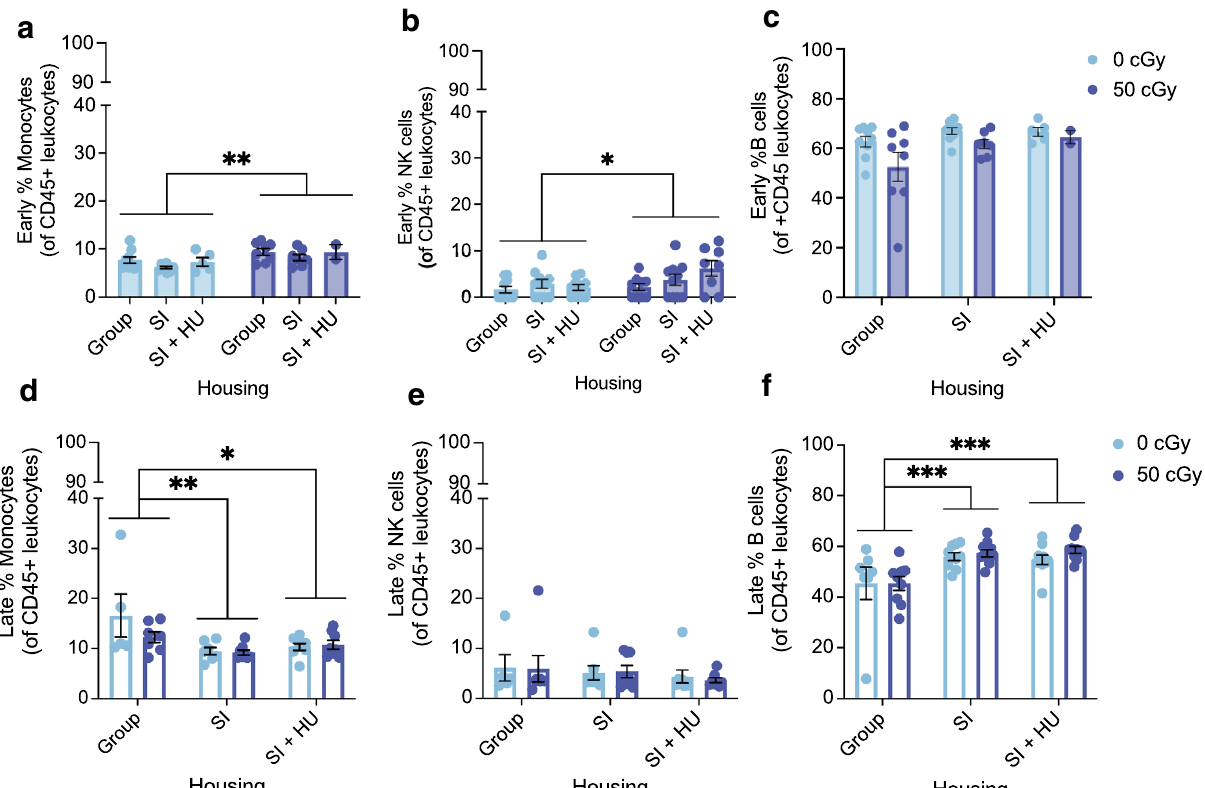
Figure 5. Combined stressors effects on early and late blood. Blood was collected from tail vein 3 weeks after GCRsim irradiation ( a, b, c ) and cardiac puncture at euthanasia ( d, e, f ). Percentages are of CD45 + cells. ( a ) Males exposed to 50 cGy had higher % monocytes than 0 cGy controls (F (1, 34) = 9.448, p = 0.004, η 2 = 0.217) (mean diff 1.921, 95%CΙ (0.651 to 3.190), p = 0.004). ( b ) There was a main effect of GCRsim on % NK cells (F(1,50) = 4.756, p = 0.034, η 2 = 0.087). Males exposed to 50 cGy had a higher % NK cells than controls (mean diff 1.801, 95%CI (0.142 to 3.459), p = 0.034). ( c ) % B cells trended toward a main effect of housing (F(1,34) = 3.179, p = 0.054, η 2 = 0.158) and of GCRsim (F(1,34) = 3.474, p = 0.0709, η 2 = 0.093). Males: n = 9 for Group 0 cGy, SI 0 cGy, n = 8 for Group 50 cGy, n = 7 for SI 50 cGy, n = 5 for SI + HU 0 cGy, n = 2 for SI + HU 50 cGy. ( d ) %Monocytes had a significant main effect of housing, F(2,37) = 6.382, p = 0.004, η 2 = 0.256. Group housed mice had higher % Monocyte levels than SI (mean diff. 5.096%, 95%CI (1.411 to 8.780), p = 0.004) and SI + HU housed mice (mean diff. 3.882%, 95%CI (0.252 to 7.512), p = 0.033). ( e ) % NK cells for males. There were no main effects of housing or GCR. ( f ) For % B cells, there was a significant main effect of Housing. F(2,49) = 11.251, p < 0.0001, η 2 = 0.315. Group housed mice had lower %B cells than SI (mean diff. − 11.203%, 95%CI (− 17.914 to -4.492), p < 0.001) and SI + HU housed mice (mean diff. − 11.287%, 95%CI (− 17.917 to − 4.656), p < 0.001). Males Monocytes and NK cells: n = 8 for SI + HU 0 and 50 cGy, SI 50 cGy, n = 7 for SI 0 cGy and group 50 cGy, n = 5 for group 0 cGy. Males B cells: n = 10 for SI + HU 0 and 50 cGy, SI 50 cGy, n = 9 for SI 0 cGy and group 50 cGy, n = 7 for group 0 cGy. * p < 0.05, ** p < 0.01, *** p <